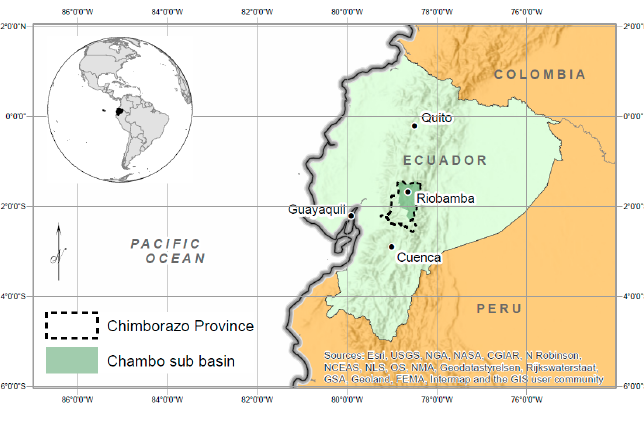
Figure 1. Location map.